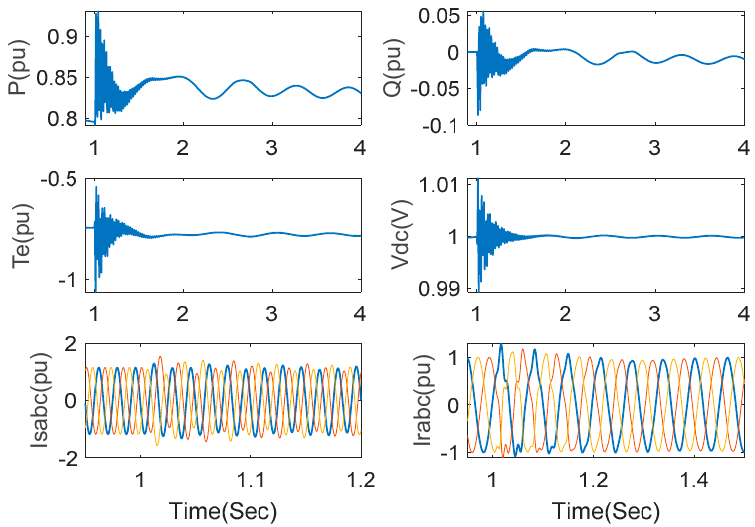
Figure 11. Responses under the proposed method with lumped uncertainties (series compensation 75% and wind speed 15 m/s).